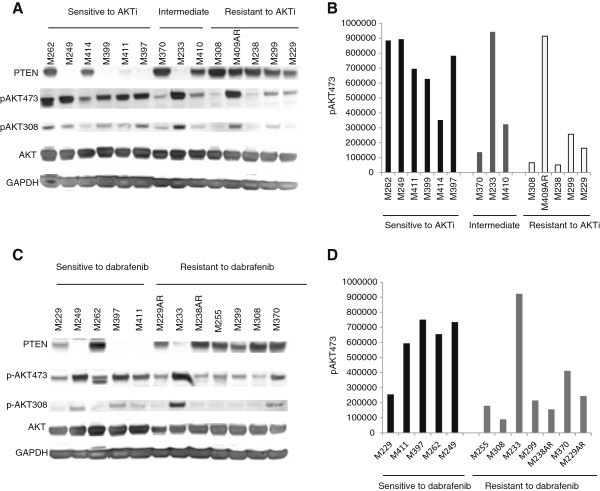
Basal levels of p-AKT and PTEN status in cell lines with differential sensitivity to dabrafenib and AKTi. Phosphorylation of AKT and PTEN status was determined by western blot analysis in a panel of cell lines with sensitivity or resistance to AKTi (A + B) or dabrafenib (C + D). Quantitation of p-AKT was done by using image quant software. Total AKT and GAPDH served as loading controls.